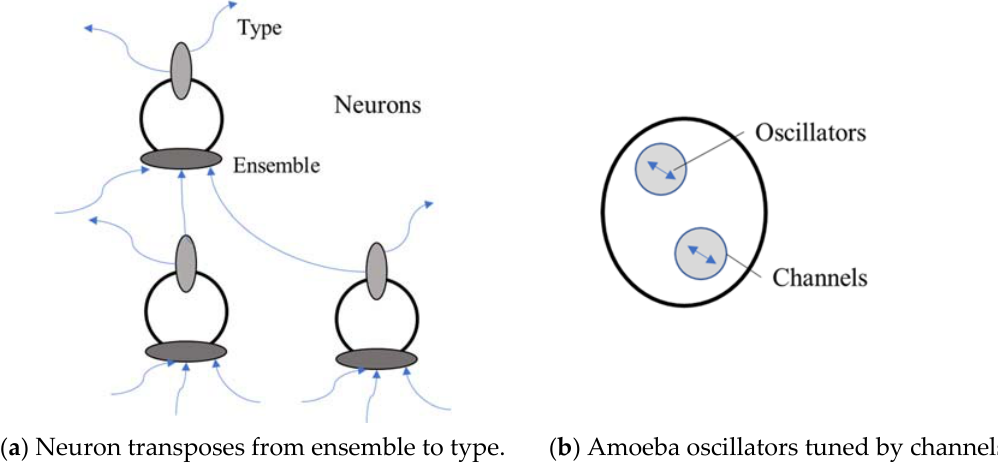
Figure 2. Network of neurons, with a comparative amoeba.